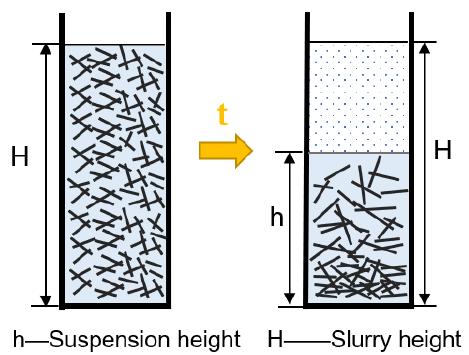
Figure 2. Schematic diagram of the suspension ratio for slurry.